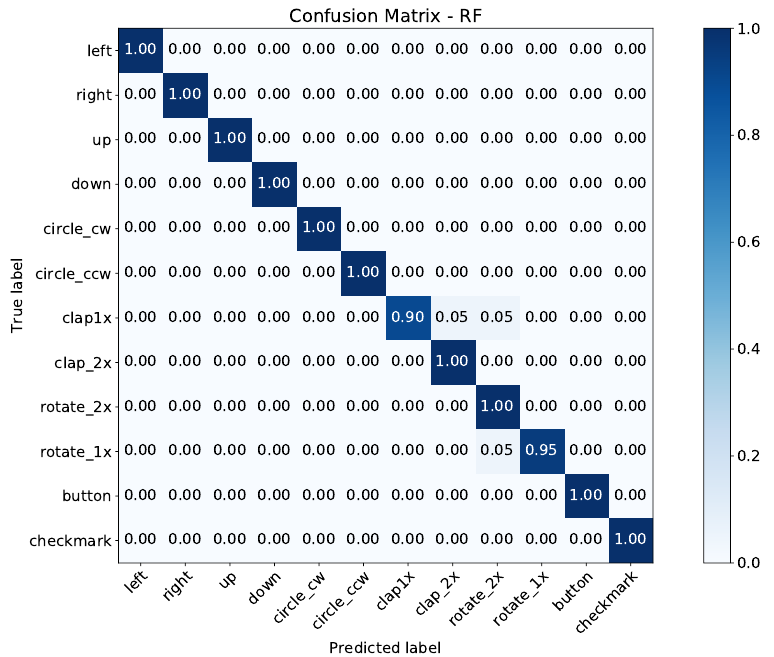
Figure 13. Confusion matrix for the best performing model trained by the watch data set of the watch session. The RF model achieved an accuracy of 98.8%, while utilizing the medium sized feature